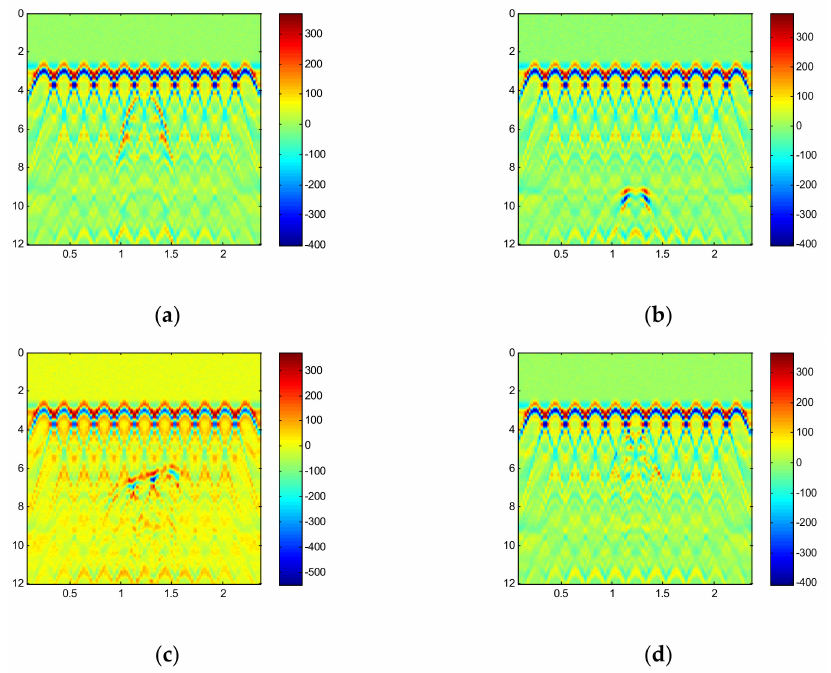
Figure 10. Clutter suppression results: ( a ) void, ( b ) cavity, ( c ) crack, and ( d ) lack of density.